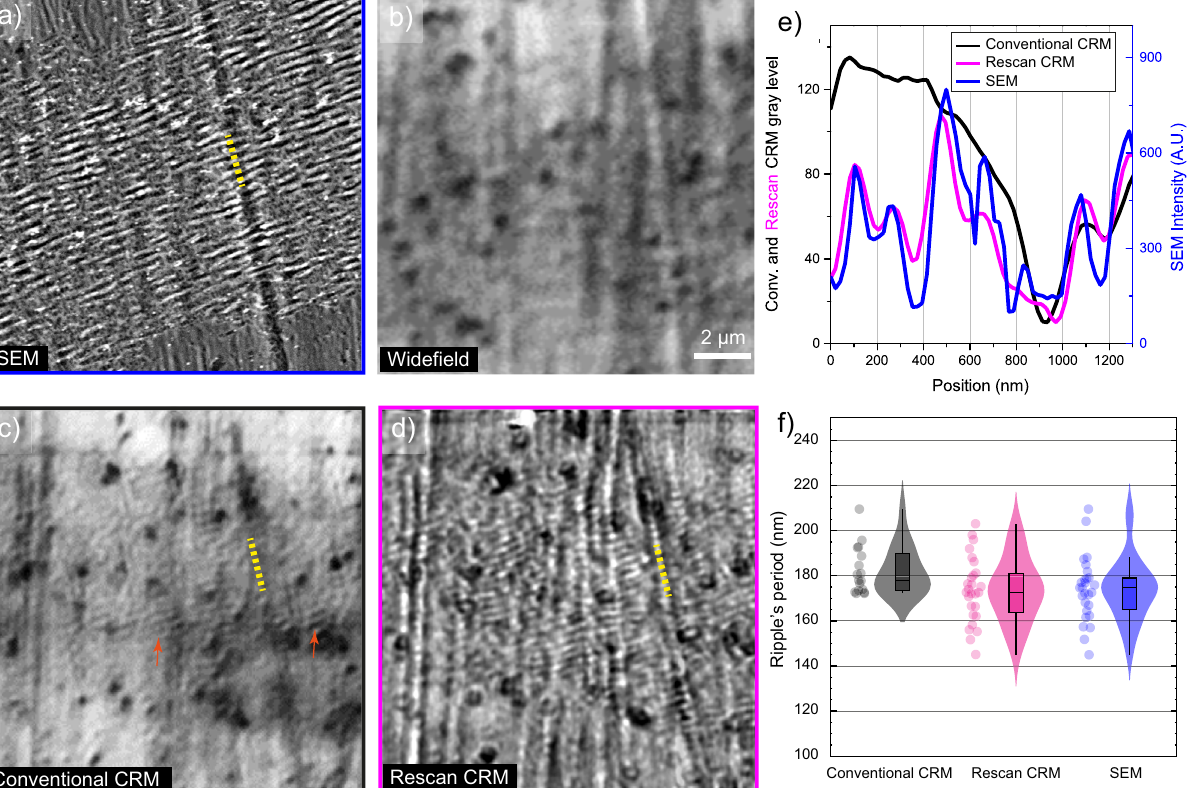
Figure 3. LSFL over titanium alloy surface created by fs laser ( (cid:31) i = 257 nm) and analyzed with different imaging techniques. ( a ) SEM, ( b ) widefield imaging, ( c ) conventional CRM, the orange arrows indicates visible LIPSS of period >180 nm, ( d ) re-scan CRM, ( e ) plot of the transversal cut shown in dashed white in ( b – d ), ( f ) LSFL period distribution with the 3 imaging methods.